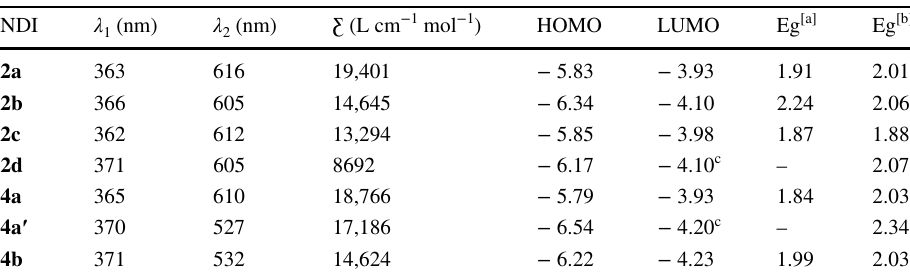
[a] Band gap energy calculated by cyclic voltammetry. [b] Band gap energy calculated from the UV–vis- ible spectrum of the NDI. [c] Values determined from the Eg obtained by UV–visible analysis and